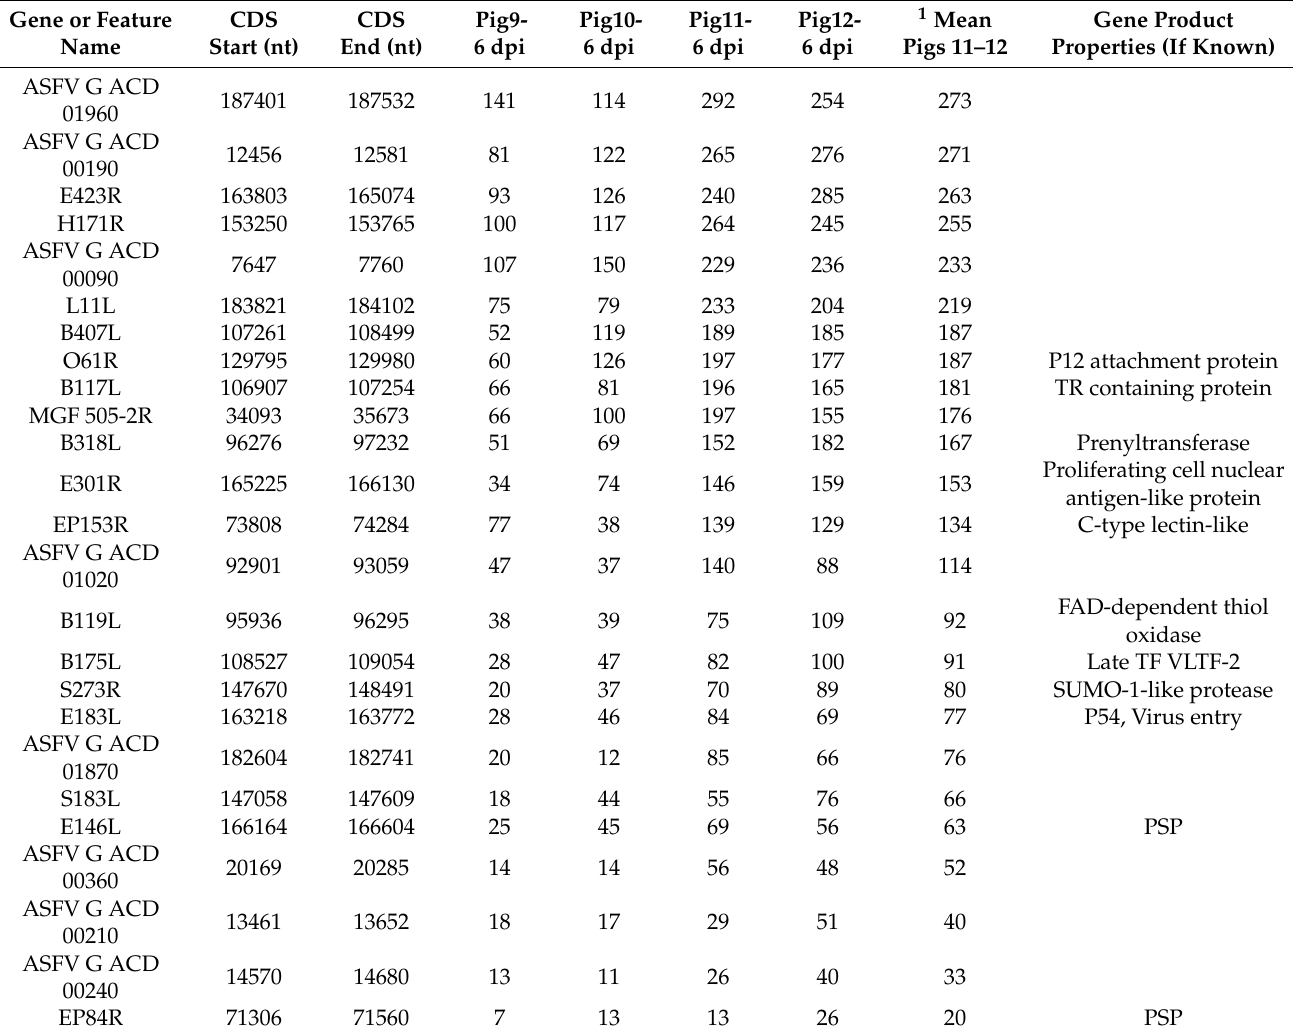
Table 4. Total number of reads for annotated ASFV genome features expressed at low levels in PBMC from infected pigs at 6